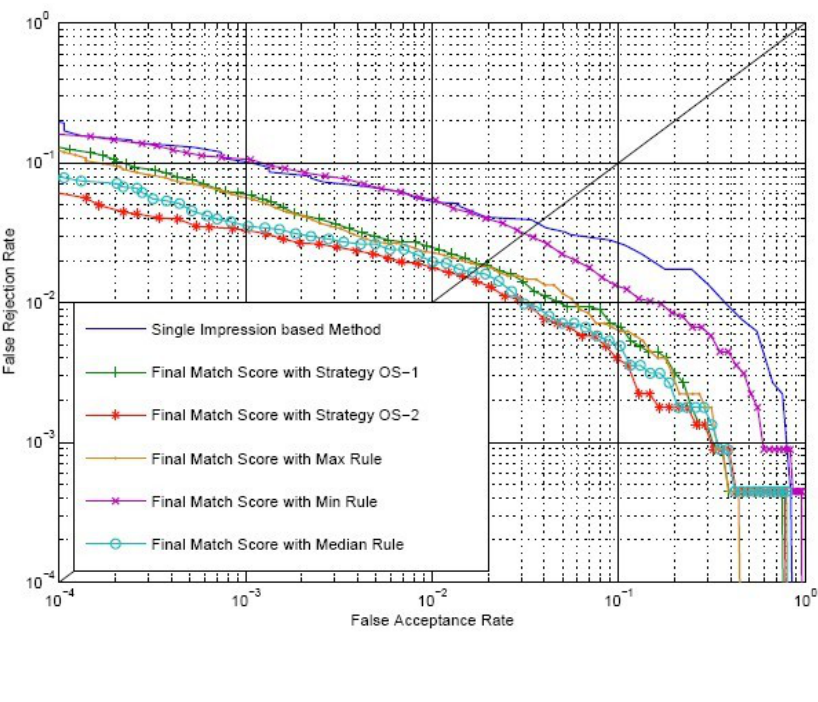
Figure 12. ROC of the final match score of our method with ω = 1.0, maximum rule, minimum rule, media rule and the conventional single impression-based method for comparison.